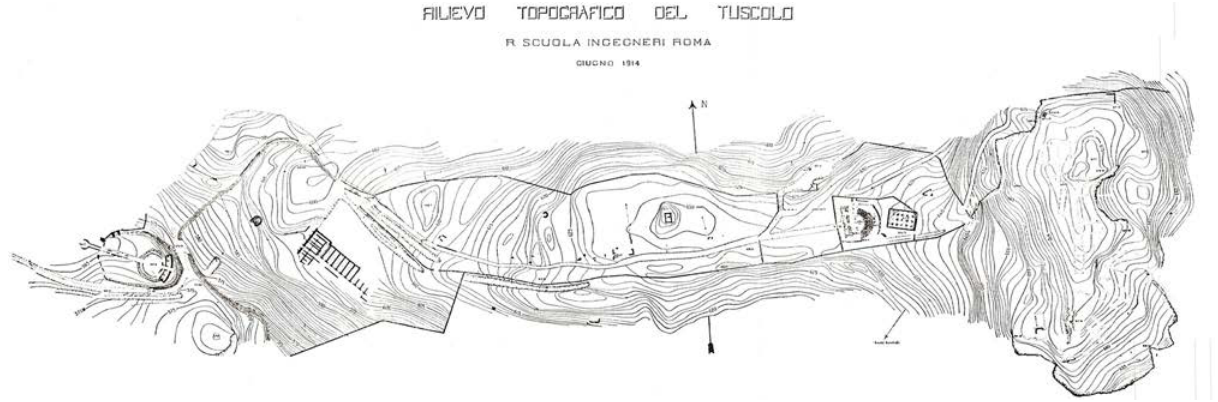
Figure 3. One of the first topographic surveys of the Tuscolo realized in June 1914 by the R. Scuola Ingegneri